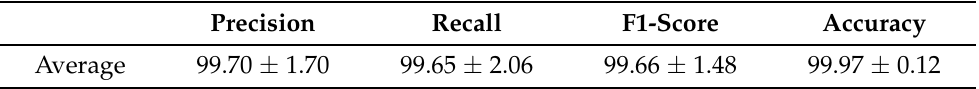
Table 5. Speaker identification performance. Average ( ± standard deviation) precision, recall, F1- score, and accuracy on the 24 actors of RAVDESS